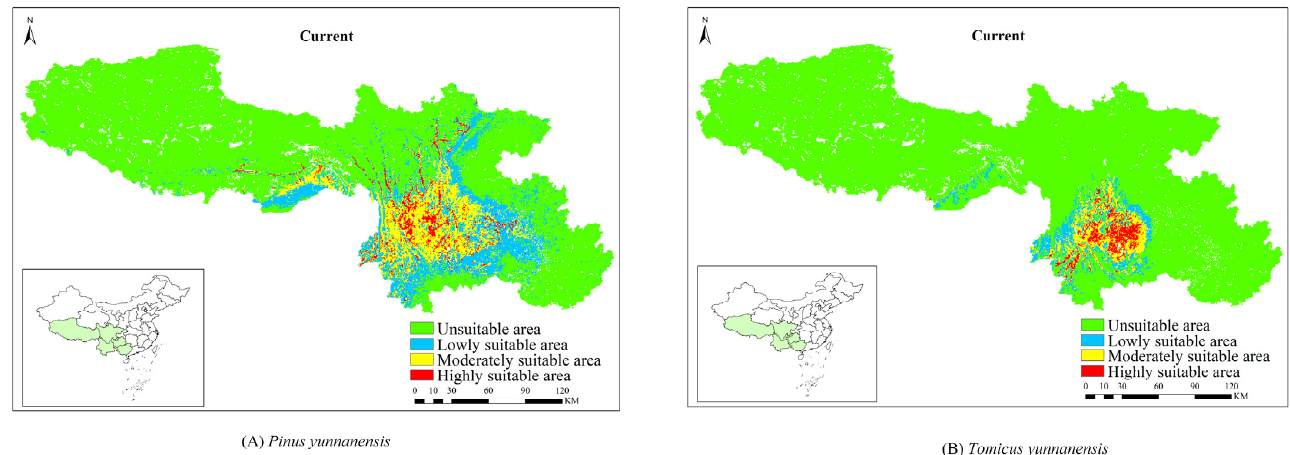
Figure 5. Potential distribution of ( A ) P. yunnanensis and ( B ) T. yunnanensis under current climatic conditions.